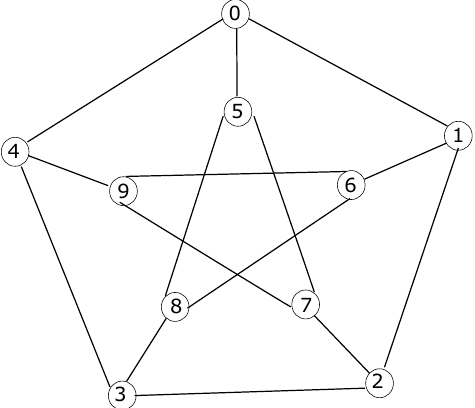
Figure 3. Petersen graph represented as a hierarchical layout.